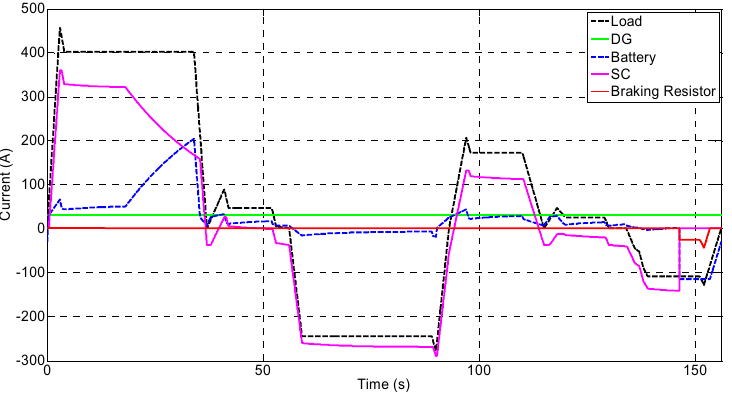
Figure 10. Output currents of three devices for operating a rated 40 ‐ ton container.